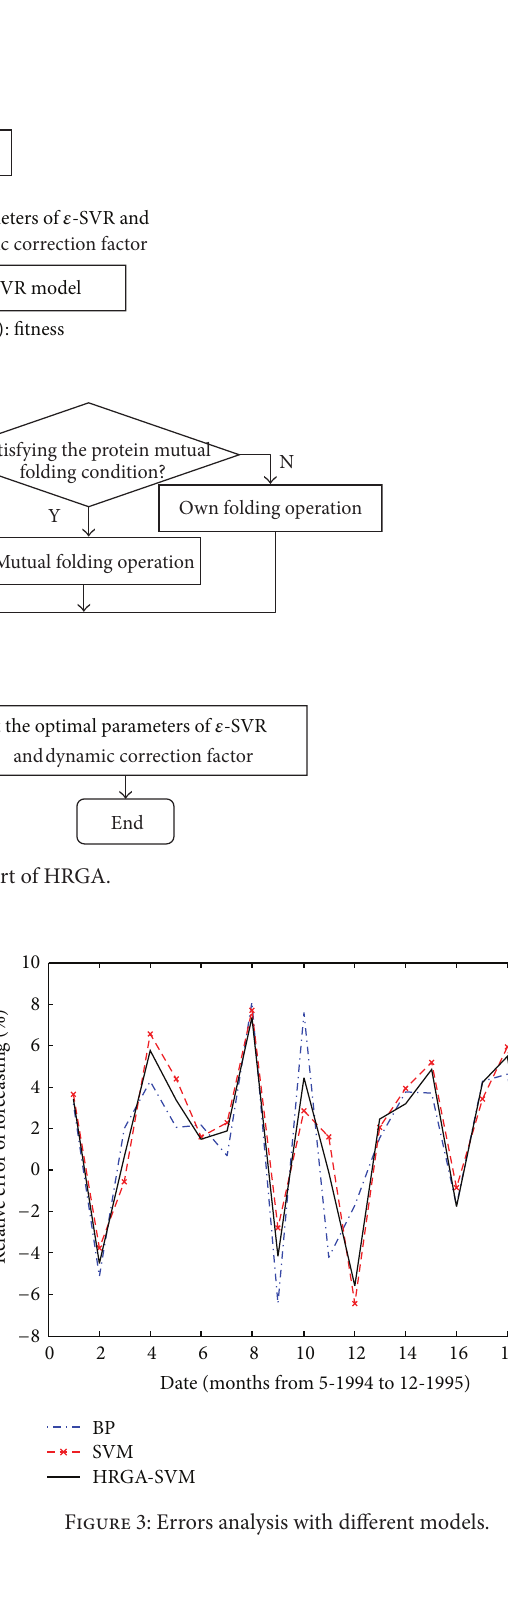
Parameter setting of HRGA- 𝜀 - 𝑆𝑉𝑅 is with population size being 100, maximum evolution generation being 150, coding length of 𝐶 being 9, coding length of 𝜀 being 8, coding length of 𝜎 being 13, coding length of 𝜀 ∗ being 8, 𝑃 𝑐 being 0.8, and 𝑃 𝑚 being 0.1.